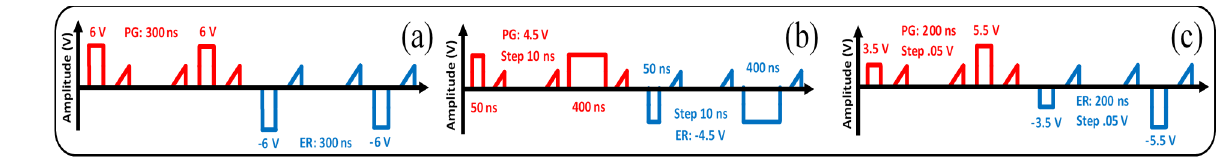
Figure 17. The different types of measurement test sequences for emulating the synaptic weight update in FeFET as ( a ) PG/ER pulse train at a constant amplitude and pulse width, ( b ) a constant amplitude sequence |4.5 V| with incremental pulse widths in 10 ns steps, ( c ) a constant pulse width sequence (200 ns) with incremental pulse amplitudes in 50 mV steps.